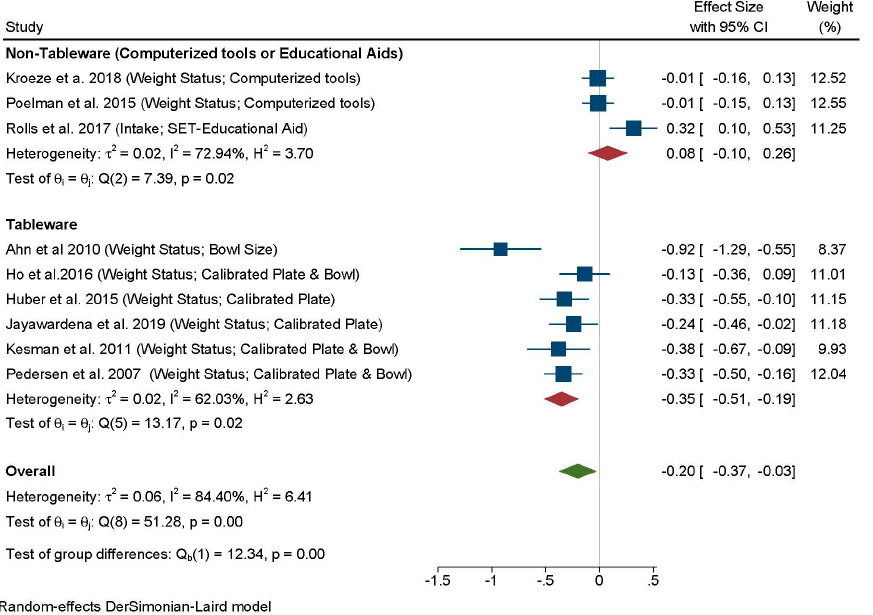
Figure 6. Forest plot for the analysis of all comparisons examining the effects of portion control tools on weight status (weight loss or BMI change) using random-effects meta-analysis. Contributing comparisons are represented by a filled square with horizontal lines, where the area of the square depicts the contribution of the study to the full analysis, and the horizontal lines indicate the 95% CIs for each study. Studies displaced to the left of a 0 line demonstrate a finding in favor of the portion control tool helping to reduce body weight, whereas those to the right demonstrate a finding in favor of the tool to promote a higher BMI or weight gain, when compared with the control condition. The diamond at the base of the plot represents the combined effect (Standardized Mean Difference) with 95% Cis.